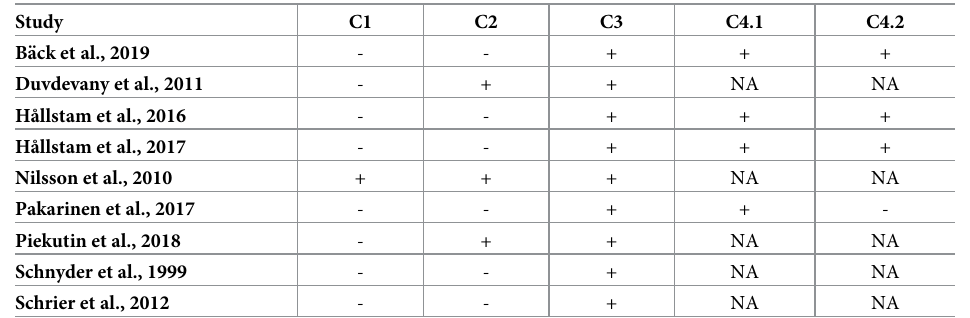
Table 1. Methodological quality assessment of individual